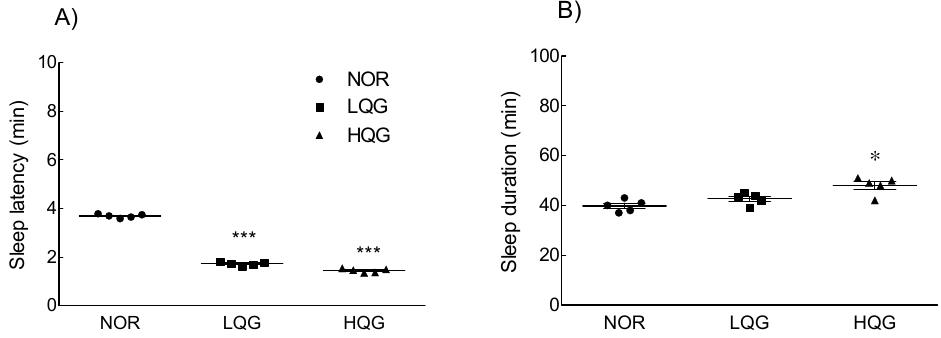
Figure 4. Effects of quercetin-3- O -glucuronide on ( A ) sleep latency and ( B ) sleep duration in mice ( n = 5/group) intraperitoneally injected with a hypnotic dose of pentobarbital (42 mg/kg). NOR: normal group; LQE: low dose of Q3G-treated group (10 mg/kg); HQE: high dose of Q3G-treated group (20 mg/kg). Values are means ± standard error of the mean for each group. * p < 0.05 and *** p < 0.001 vs. NOR.